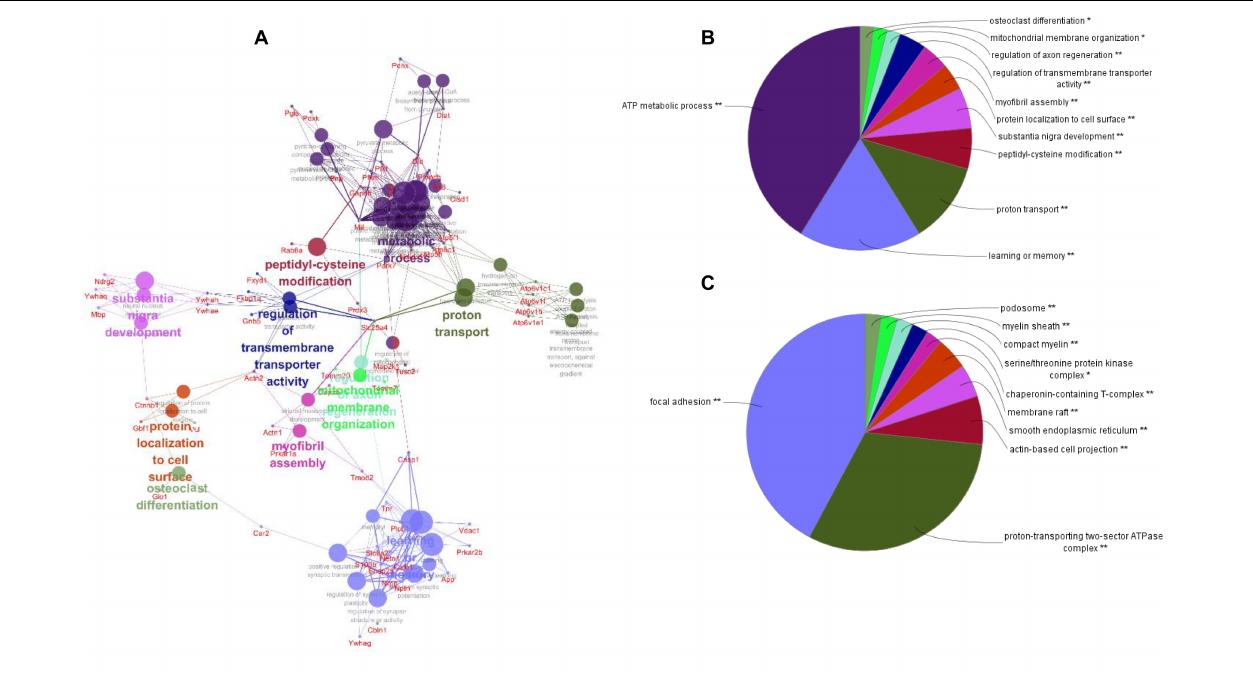
FIGURE 5 | The network of biological processes for the differentially expressed proteins (DEPs) (A) . The biological processes [Gene Ontology (GO) category] of the DEPs were visualized using ClueGO software ( p ≤ 0.05, kappa ≥ 0.4), and only the most significant interactions are shown. Each node represents a biological process, and the size of each node reflects the enrichment significance of the GO terms. The edges represent connections between the nodes. The color of the node represents the class. Mixed coloring represents multiple classes. Ungrouped terms are not shown. The distribution of DEPs according to biological process (B) and cellular location (C) was determined by ClueGO ( p ≤ 0.05, kappa ≥ 0.4), and only the most significant terms are shown. * P < 0.05, ** P <